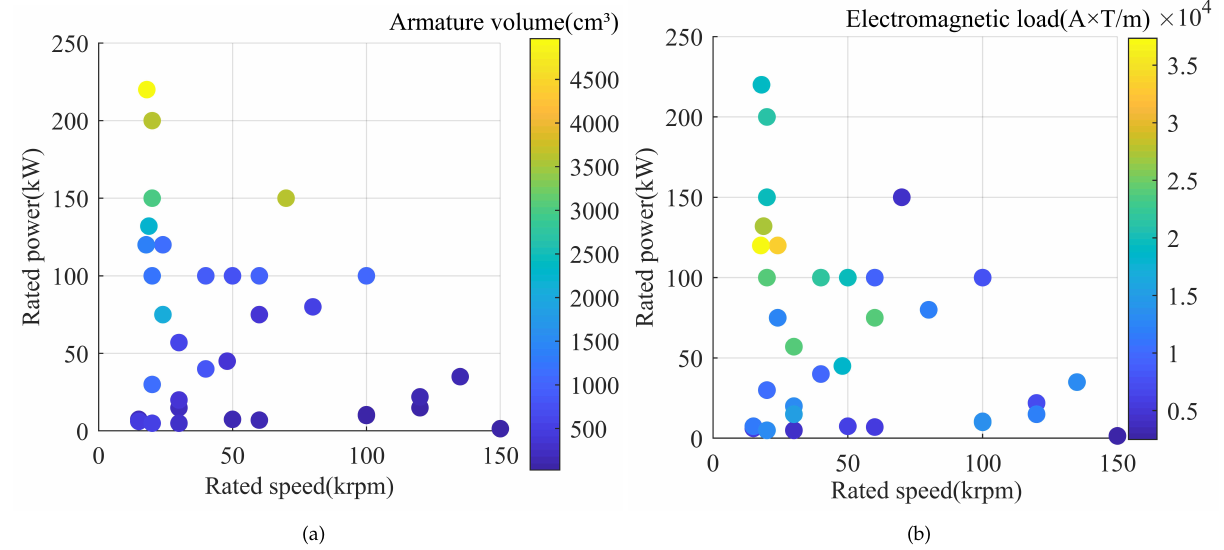
L a and AB δ distribution: ( a ) Distribution of D 2 Figure 4. D 2 i 1 ( b ) Distribution of AB δ of high-speed PM